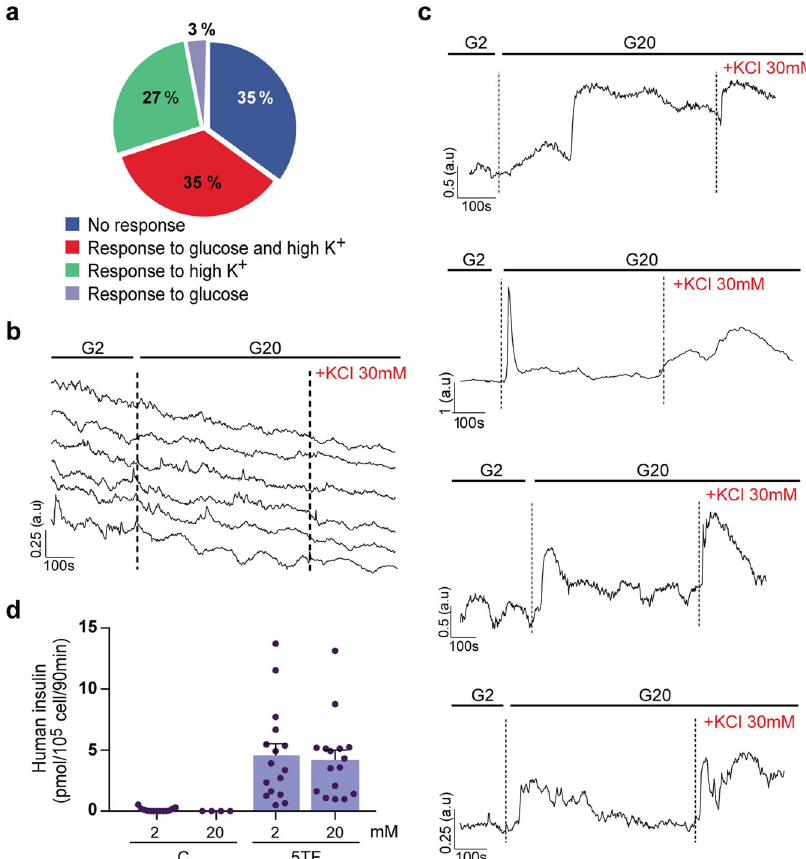
Fig. 4 5TF cells increase intracellular calcium in response to glucose and KCl. 5TF cells were loaded with the calcium indicator Fluo-4-AM at day 10 of the reprogramming protocol. Single-cell imaging to detect cytosolic calcium was performed in the following sequence: low glucose (2 mM, G2), high glucose (20 mM, G20) and membrane depolarization with KCl (30 mM). a Quanti fi cation of the frequency of cells ( n = 200, from six independent reprogramming experiments) that responded to glucose, membrane depolarization elicited by high potassium or both. Representative measurements of dynamic Fluo-4 fl uorescence for ( b ) six fi broblasts and ( c ) four 5TF cells. d In vitro insulin secretion by 5TF cells. ELISA determination of secreted human insulin by control fi broblasts ( n = 4 – 13) and 5TF cells ( n = 16) under non-stimulatory conditions (glucose 2 mM) and under stimulatory conditions (glucose 20 mM). Data are mean ± SEM and correspond to six independent reprogramming experiments, 2 – 4 biological replicates per